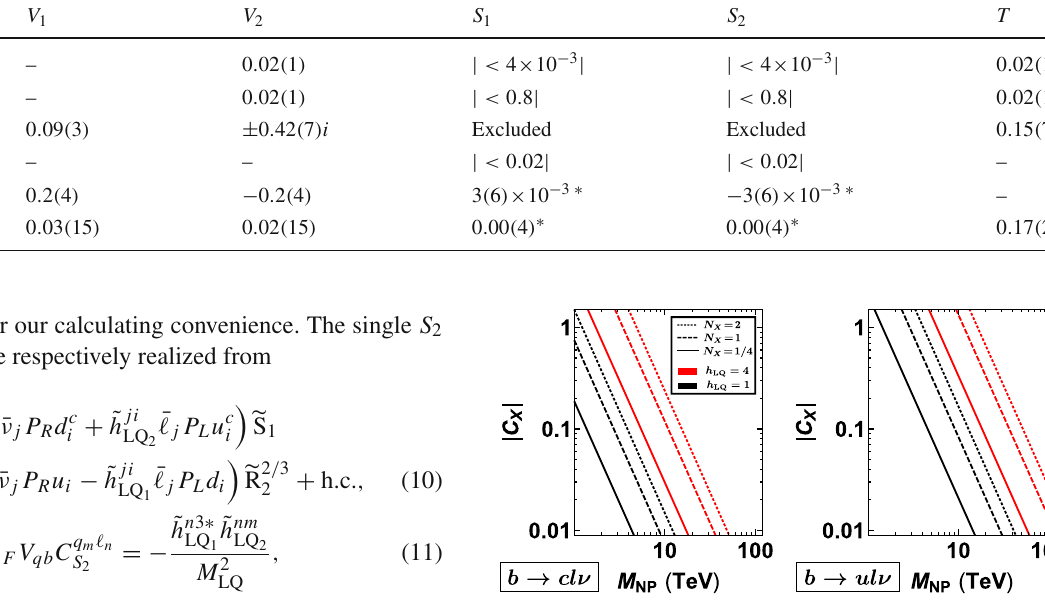
Fig. 1 Relations between the LQ mass and the WC at the NP scale by fixing the LQ coupling the present LQ models. Then, one can check the accessible LQ mass from the plot. For instance, | C cl produced with M LQ (cid:2) 10 TeV for h LQ (cid:2) 1 in b → cl ν . The mass could be M LQ ∼ 50 TeV at maximum if we allow the coupling as large as h LQ =